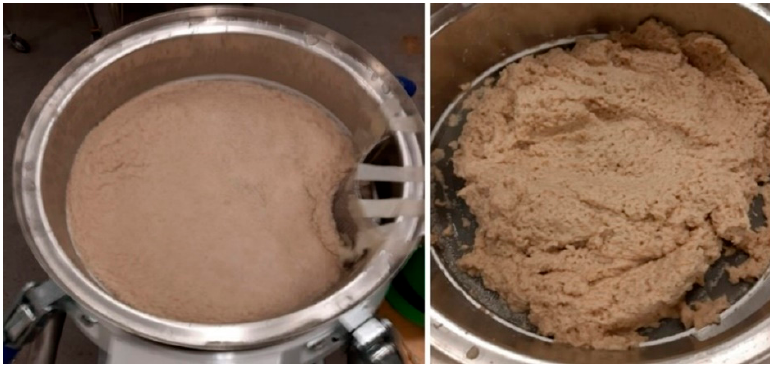
Figure 1. A. oryzae biomass after 48 hours of cultivation.